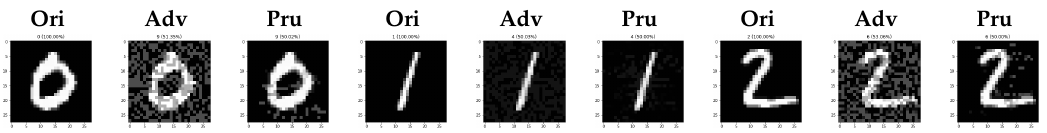
Figure 2. Comparison of original, adversarial, and pruned image: by applying perturbation pruning algorithm to the generated adversarial example, we can remove the inessential